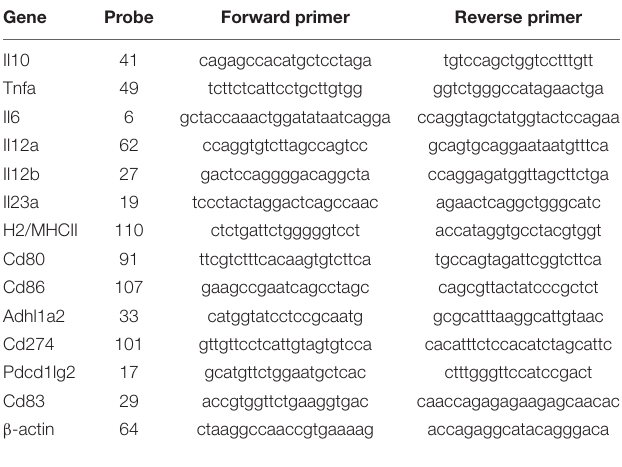
TABLE 2 | List of genes, Universal ProbeLibrary (UPL) probes and primers used for